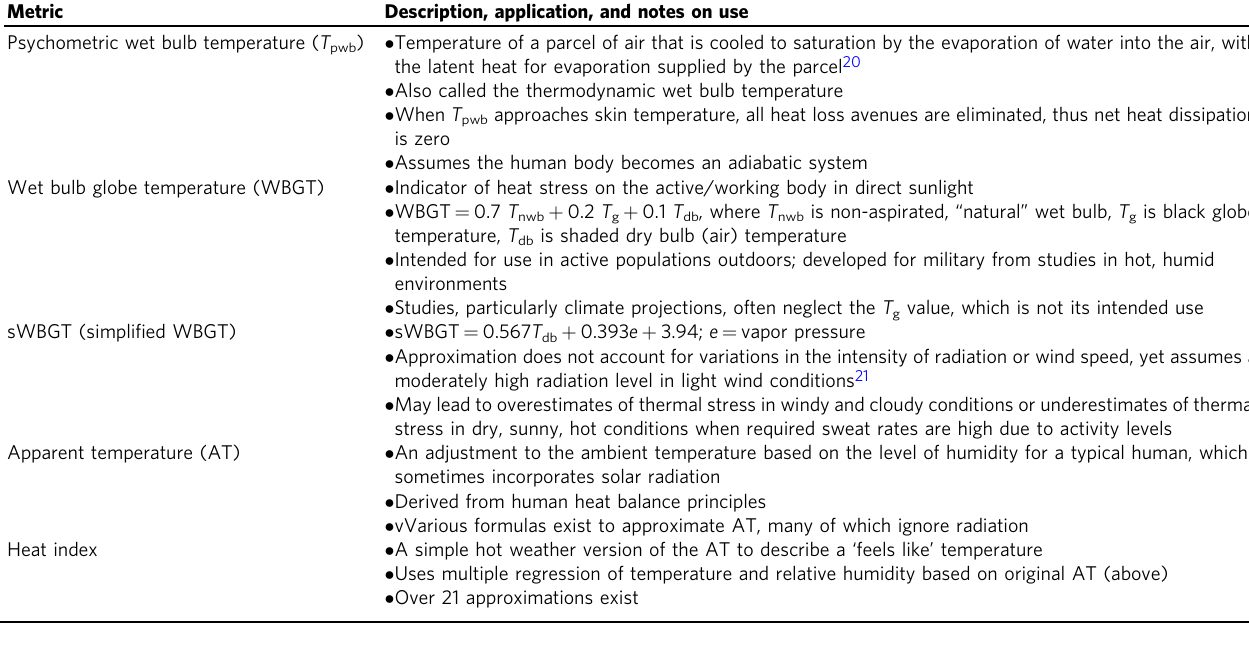
Table 1 Heat metrics or thermal indices often used within climate model projections in recent studies. Metric